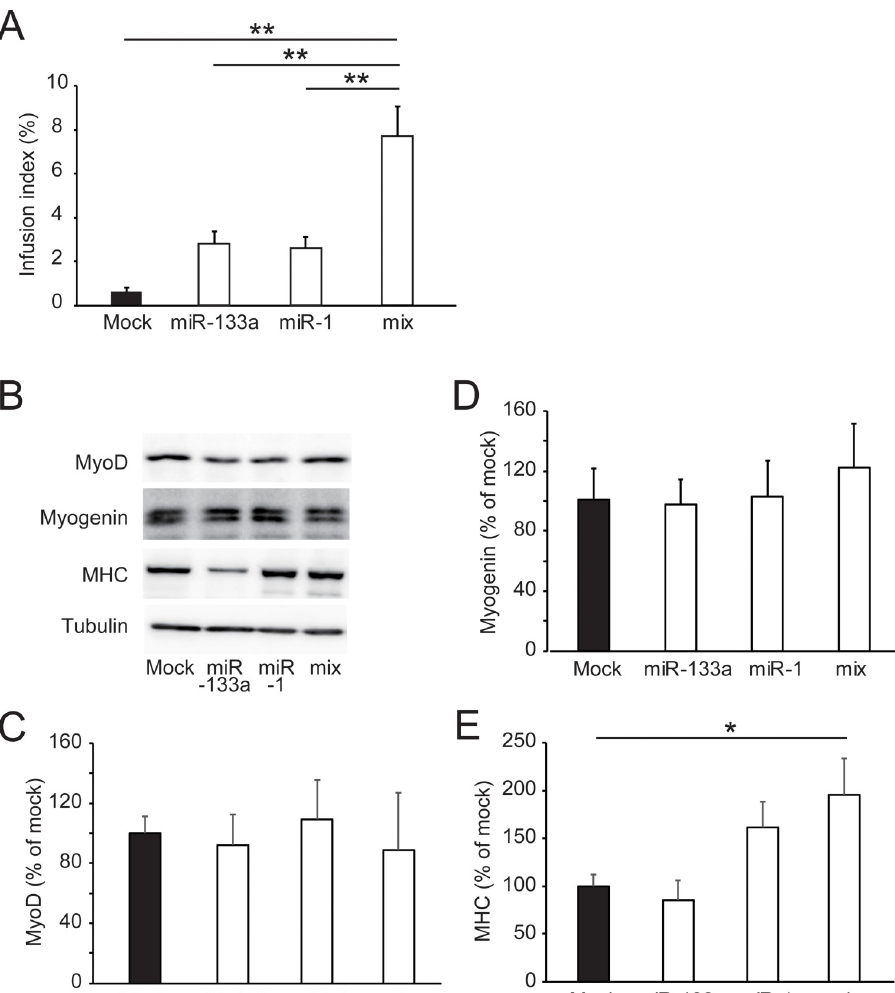
Fig 5. Effect of miRNA mimic transfection on myogenic differentiation in replicative senescent C2C12 cells. Panel A shows the infusion index after 7 days of differentiation in cells transfected with miR-133a, miR-1, or both. Mock cells were transfected with a negative control miRNA. Data are presented as means ± SE (n = 10 dishes). �� P < 0.01 (Tukey–Kramer test). Panels B–E show representative blots of MyoD1, myogenin, MHC, and tubulin (B), and quantitative data (C–E) in cells after differentiation for 7 days. The band density of MyoD1, myogenin, or myosin heavy chain (MHC) was normalized with that of tubulin. The normalized density was compared with the average of the normalized density in the mock group. Data are presented as means ± SE (n = 5 dishes). � P < 0.05 (Tukey–Kramer